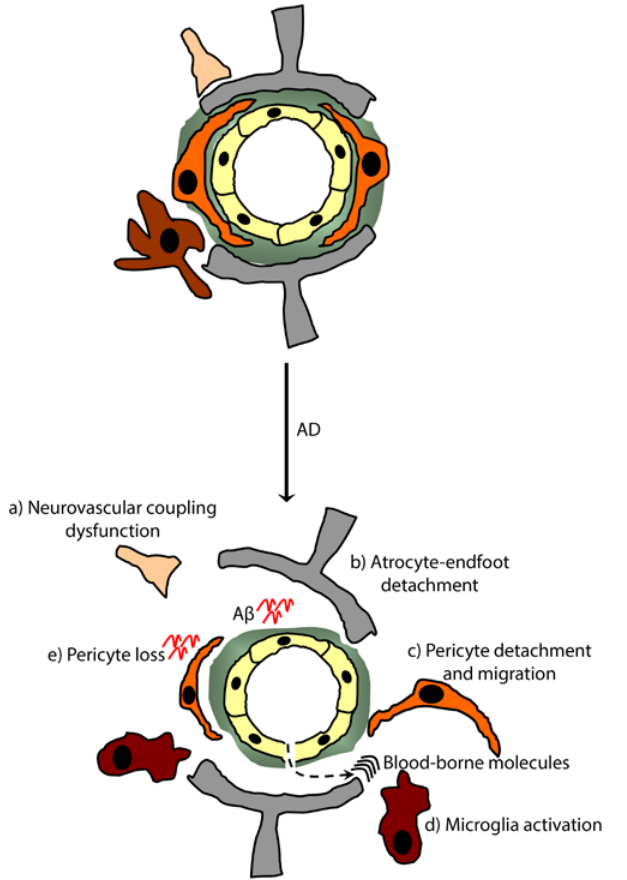
Figure 4. Pericyte responses upon NVU remodeling in Alzheimer’s disease (AD). In